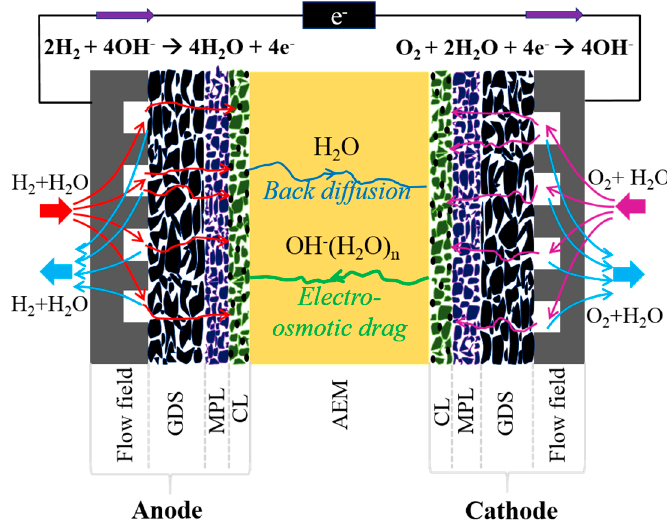
Figure 1. Schematic diagram of a typical anion exchange membrane fuel cell (AEMFC).